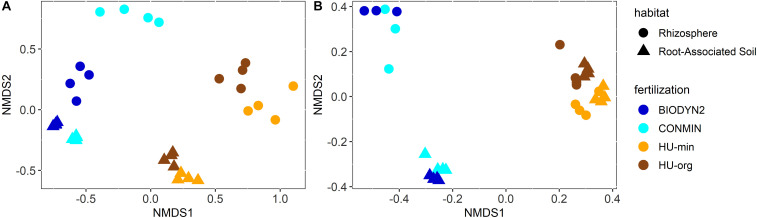
Two-dimensional diagram of non-metric multi-dimensional scaling (NMDS) analysis of calculated Bray-Curtis distances between (A) bacterial and archaeal community compositions or (B) fungal community compositions in root-associated soil and the rhizosphere of lettuce (cv. Tizian) grown in soils from HUB-LTE (HU-org, HU-min) or DOK-LTE (BIODYN2, CONMIN). NMDS analyses are based on relative abundances. Stress = 0.11 (bacterial and archaeal communities) and 0.07 (fungal communities).